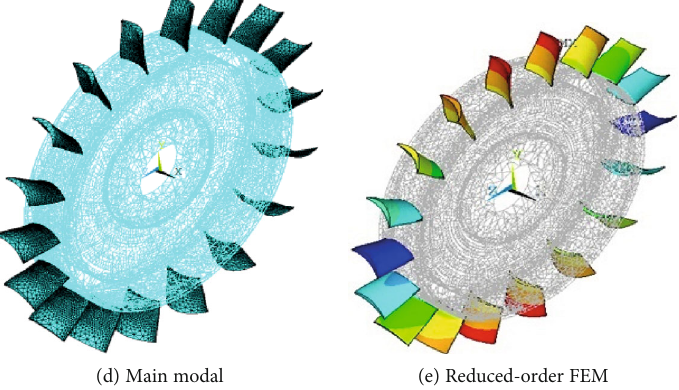
Figure 3: Improved dynamic substructure FEM of mistuned blisk.